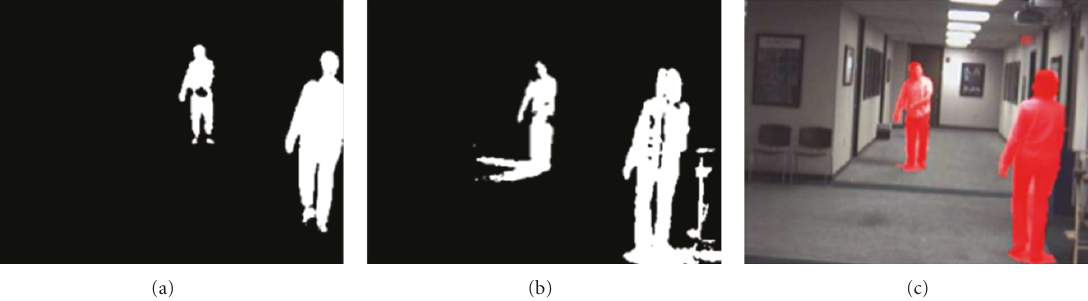
Figure 8: Example of fusion of video and thermal imagery: (a), FG obtained from the thermal camera; at the center, FG obtained from the video camera; (b), their fusion result